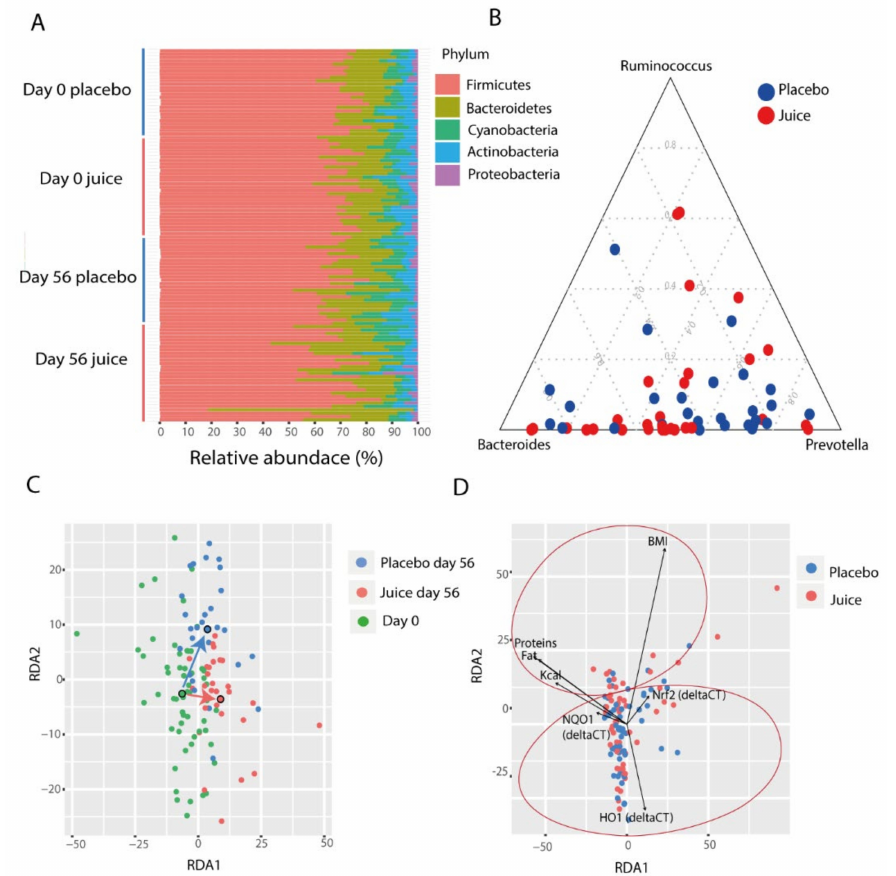
Figure 6. ( A ) Phylum-level composition of the gut microbiota divided by groups (juice, placebo) and time points (day 0, day 56). ( B ) Abundance of major enterotype genera at day 0. ( C ) Redundancy analysis (RDA) of the gut microbiota shows a grouping of samples. Each point represents a sample and the colors represent the groups (placebo day 56, juice day 56, day 0). The larger circles show the centroids for each group. ( D ) The significant parameters correlated with the gut microbiota are represented in the redundancy analysis plot. Significant correlation is present with nutritional parameters (top of the plot) and Nrf2 gene, NQO1 , and HO-1 transcript levels (bottom of the